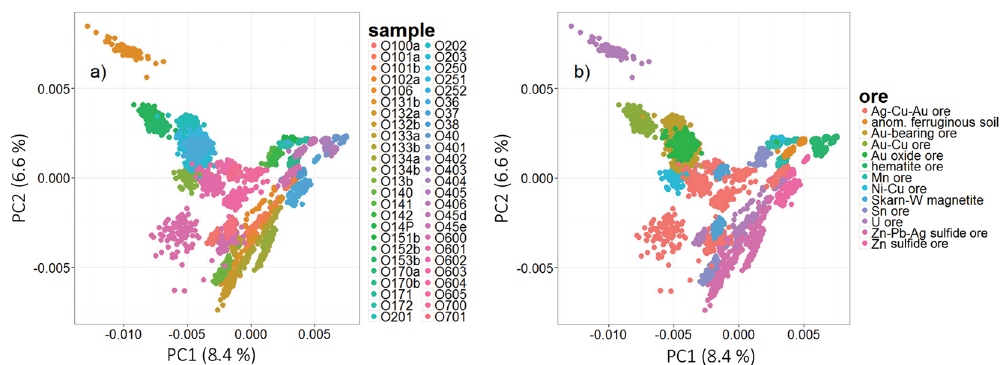
Figure 4. PCA scores for the analysis yielded from 1D LIBS data of sedimentary ore CRMs, where data were classified according to ( a ) individual sample and ( b ) specific